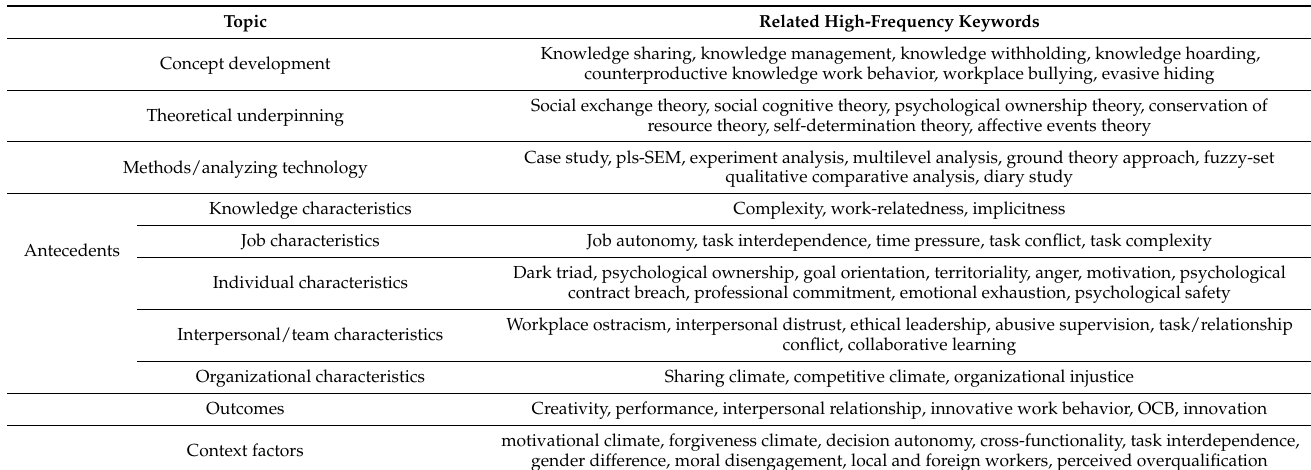
Table 5. Identified research